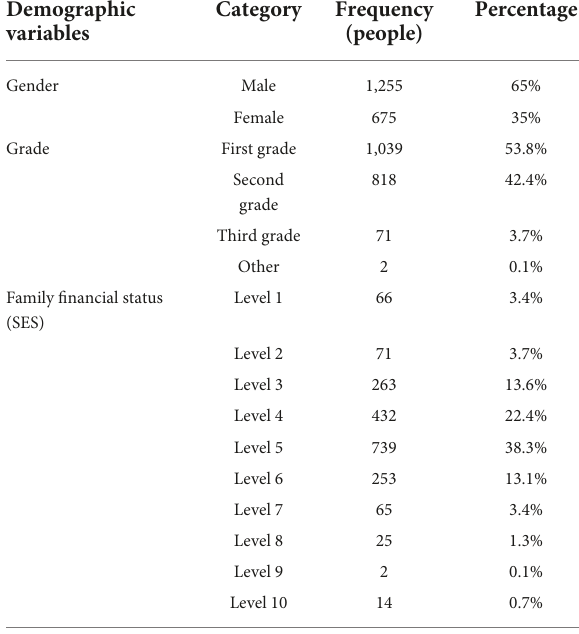
TABLE 1 Demographic characteristics of the